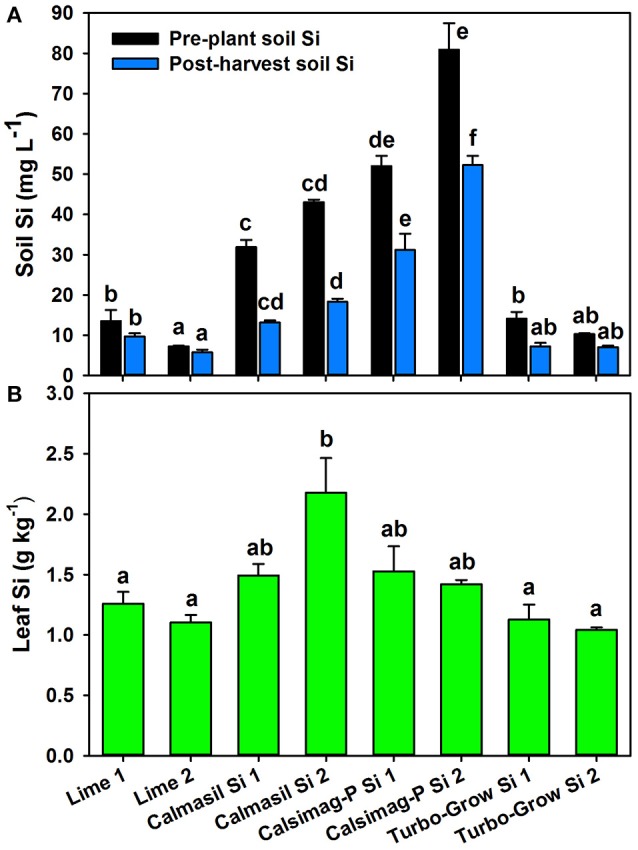
Silicon concentrations in soil (A) and third leaf (B) following application of different silicon sources (represented on X-axis) at lower and higher rates (Si 1 and Si 2; see Table 4) in Trial 2. Product and silicon application rates are specified in Table 4; the lime control was applied at the same product rates as Calmasil. In (A), black bars represent pre-plant soil and blue bars represent post-harvest soil; mean values for bars of the same color and with the same letter/s above them are not significantly different. In (B), mean values for bars with the same letter above them are not significantly different (Holm-Sidak test, P < 0.05; ANOVA, P < 0.001 for soil and leaf Si). Error bars are standard errors.